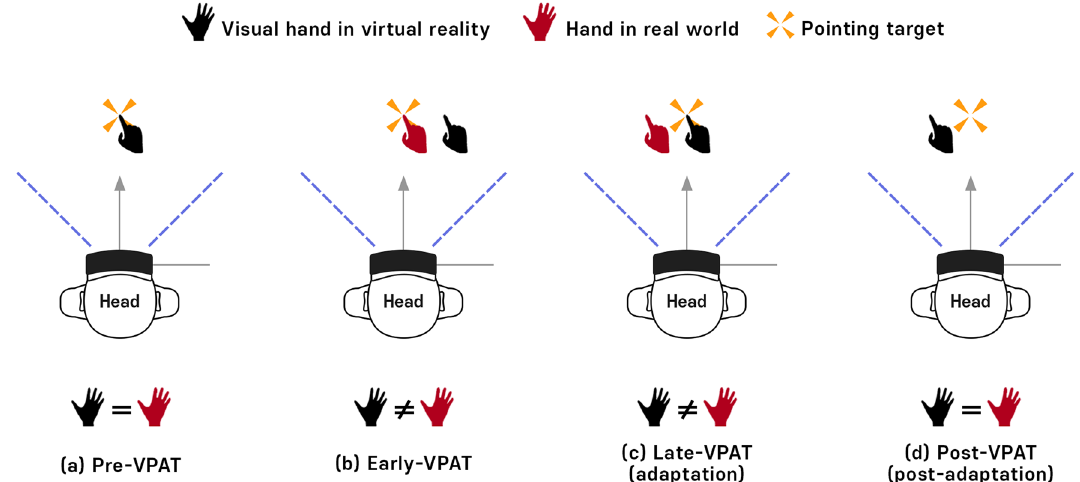
Figure 1. Concept of virtual prism adaptation therapy (VPAT). ( a ) Pre-VPAT: The position of the virtual hand in virtual reality and the real hand are always the same. ( b ) Early VPAT: Virtual hand shifted to the right side from the real hand. Virtual and real hand positions are not the same. ( c ) Late VPAT (adaptation): After adaptation, the virtual hand will reach the target correctly, but the real hand will deviate to the left side from the object. ( d ) Post-VPAT (post-adaptation): Virtual and real hand are in the same position and the real hand still points the left direction from the Concept of the VPAT system. VR systems with head mounted displays provide immersive visual feed- back. Hand tracking with a head mounted display eliminates the gap between the virtual hand location and the location of the virtual object in virtual space. This clearly differs from systems using a 2D or 3D display, stylus, and mouse. Synchronization of the coordinate system of VR contents and hand tracking coordination can induce more realistic interactions with virtual objects. It is also possible to intentionally misalign the virtual hand and virtual object during the pointing action. This may be similar to a visual field shifting in the PA para- digm using prism goggles. However, while prism goggles shift all visual fields, our VPAT system only shifts the virtual hand trajectory in the immersive VR. The virtual hand shift using our VPAT system induces initial pointing errors. In the condition without VPAT mode (no virtual hand shift), the subject directly points the virtual target (Fig. 1a). During the early VPAT period, the subject’s virtual hand is shifted to the right from the VR target (Fig. 1b), which might make the subject per- ceive the real target location to the left of the initial pointing location. During the late VPAT period, the subject adapts to VPAT mode and the pointing errors of the virtual hand to the target diminish and finally disappear (Fig. 1c). After the VPAT mode is switched off, the subject’s real hand will point to the left of the target (Fig. 1d), if the adaptation effect of VPAT is similar to conventional PA therapy. Hardware and software design of the VPAT system. The VPAT system uses the Oculus Rift DK2 with Runtime Software version 2.1.2 (Oculus VR, LLC, California, USA, https:// devel oper. oculus. com/ downl oads/ unity/) as a head mounted display (HMD), while the Leap Motion sensor with Orion software version 3.1.3 (Leap Motion, CA, USA, https:// devel oper. leapm otion. com/ relea ses/? categ ory= orion) is mounted on the front of the HMD for hand tracking (Fig. 2a). Before projecting the user’s hands into the virtual space in real time, the hand skeleton dummies detected by the Leap Motion sensor are rotated based on the longitudinal axis for the visual hand shift. The VR environment was created with Unity3D version 5.4.3 (Unity Technologies, CA, USA, https:// unity 3d. com). The environment is based on a general living environment and composed of an office with a desk (Fig. 2b). The objects used in the environment were constructed to avoid interfering with the view or interaction with the target. The red cross marked on the bookshelf is used to calibrate the body and center of vision. A white ball is used as the target for pointing. The remaining trial time is indicated by a health bar, and to the right is an icon showing the current task. The device was calibrated to determine where the target was located and visible. Figure 2c shows feedback that can only be seen when the index finger is within the visible area. The virtual hand is only visible beyond the invisible area shown in Fig. 3b. Even if the index finger does not exactly touch the target, the virtual hand becomes visible when the index finger reaches above the target’s z distance. The target is a 6 cm diameter ball hanging from a rod. The virtual hand is not displayed until it is within a visible area, set to a depth similar to the target. When pointing at a target in a trial, the hand is prevented from being controlled accurately via real-time visual feedback. The location of a target object on a virtual table is defined as angle θ from the center of view. In the initial calibration phase, the distance of the object is specified as a comfortably reachable distance allowing the user to touch them (Fig. 3a). First, the coordinate systems between the head and hand should be co-aligned. The coordinate system of the visual hand is transformed by the angle ϕ in relation to the head center (Fig. 3b). If a